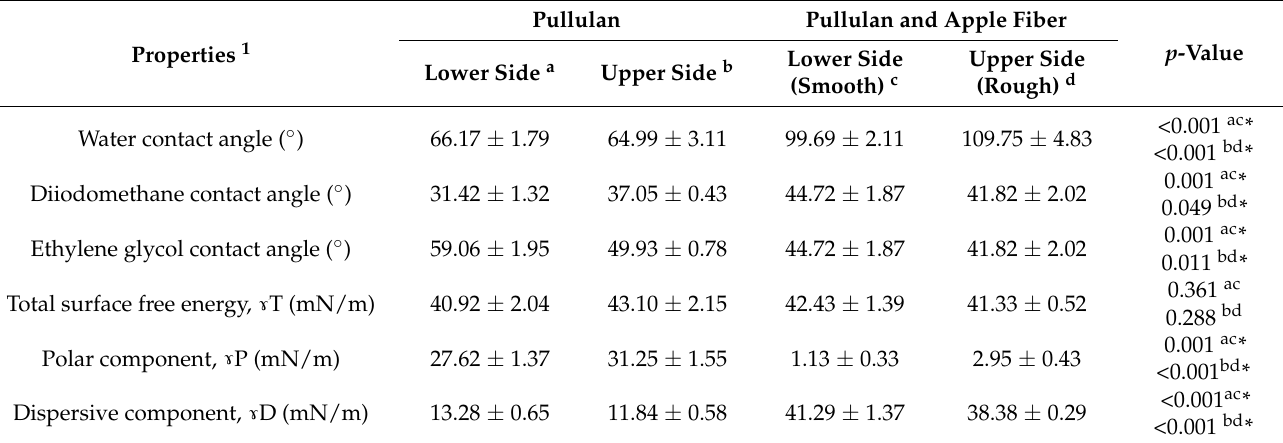
Table 3. Contact angles and surface free energy of the biocomposite films.